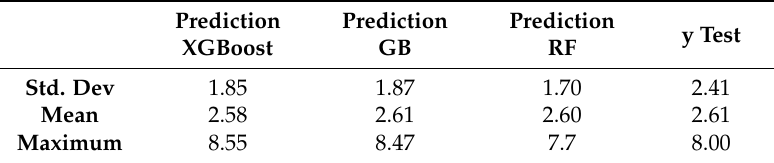
Table 5. Comparison between Y-test and Model